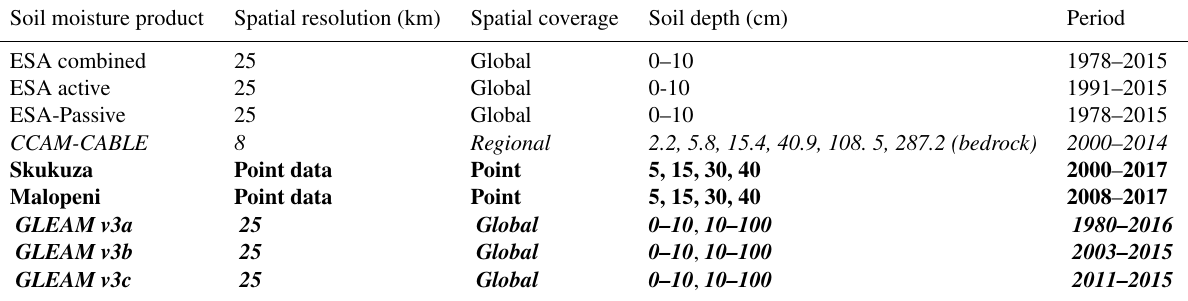
Table 1. Overview of soil moisture datasets: satellite (normal font) in percentage, modelled (bold and italic), simulation (italic) and in situ observations (bold) presented as a ratio (m 3 m − 3 ) of soil to moisture per unit area.